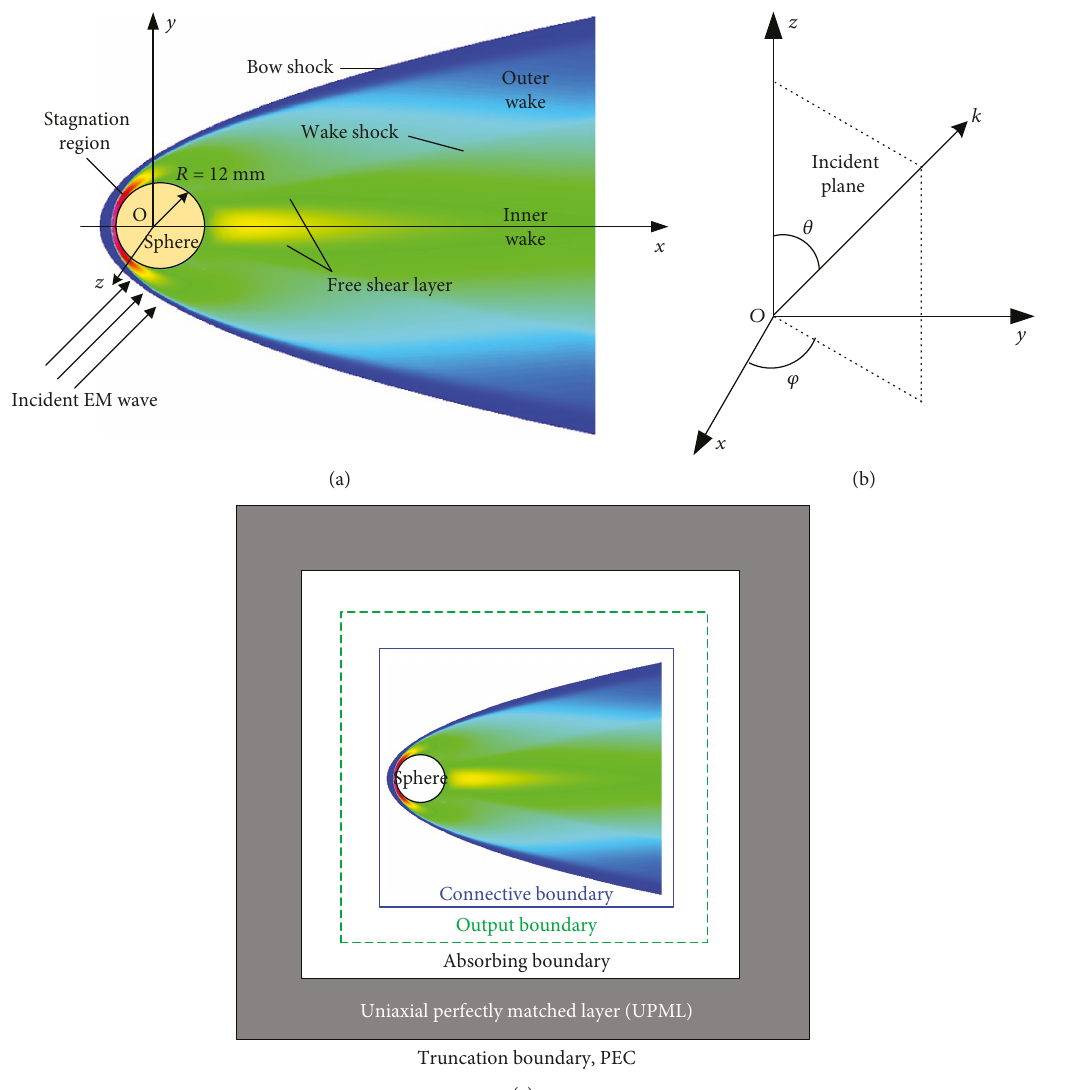
Figure 4: Illustrations of (a) a PEC sphere surrounded by a hypersonic fl ow fi eld. (b) De fi nitions of incident angles θ , φ . (c) Transverse cross-section plane of the electromagnetic simulation